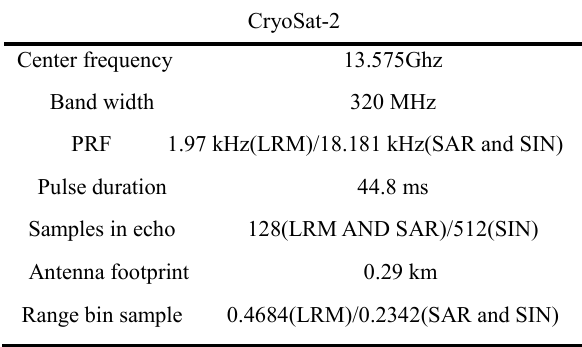
Table 1. Detailed specifications of